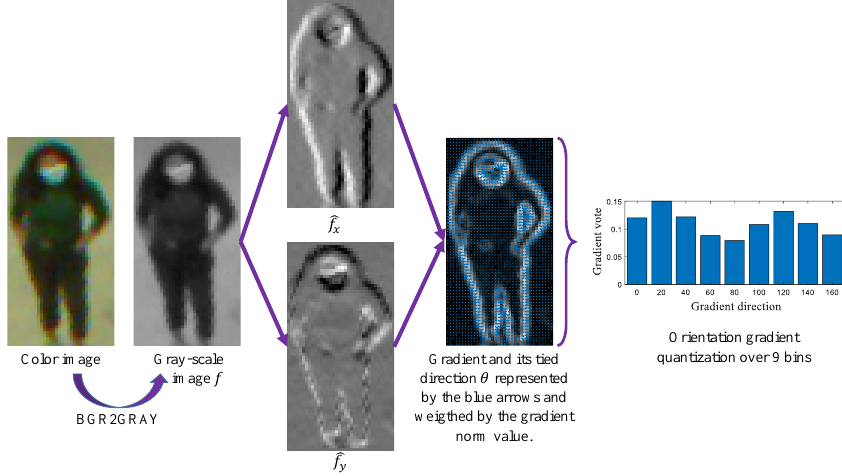
Figure 3. HOG computation on a full gray-scale image using [ − 1 0 1 ] and [ − 1 0 1 ] t